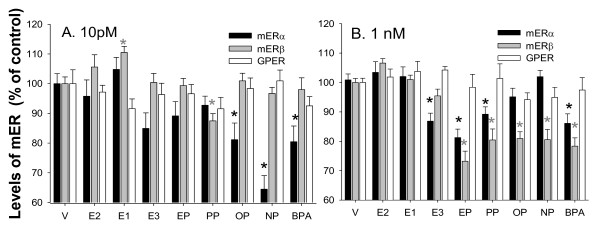
Movement of mERs in or out of the membrane in response to different physiologic (E2, E1, or E3 ) or environmental (EP, PP, OP, NP, or BPA) estrogens. Levels were assessed by a quantitative plate assay measuring immunoreactive protein levels in the plasma membrane for ERα, ERβ, and GPER, after treatment with (A) 10 pM of estrogenic compounds or (B) 1 nM of estrogenic compounds for 5 min. *p < 0.05 compared to vehicle (V) control cells. #:p < 0.05 compared to E2, E1, or E3 alone.